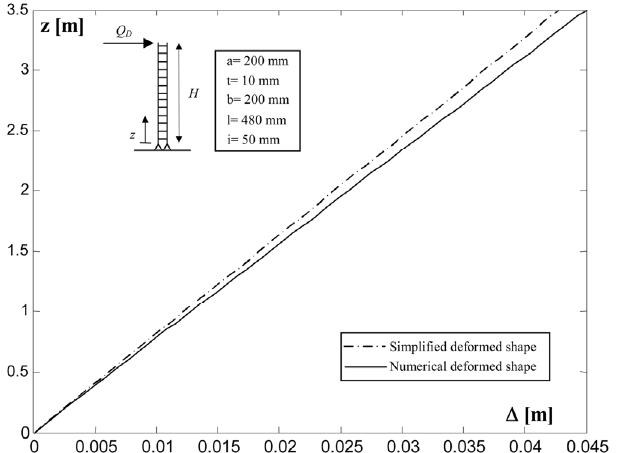
Figure 8. Model A_2: Theoretical vs. pushover analysis force displacement relationship.